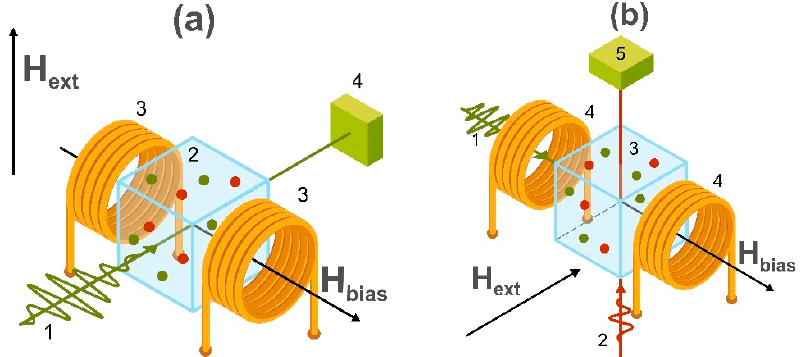
Figure 8. Schematic images of two main geometries of the optically pumped atomic magnetometer. In ( a ), the measuring scheme includes a circularly polarized pump beam (1) passing through the vapor cell (2) placed into the applied external magnetic field (H ext ) and bias magnetic field (H bias ) generated by the Helmholtz coils (3). The detecting system is shown as (4). In ( b ), the measuring scheme includes a circularly polarized pump (1) and linearly polarized probe beams (2) passing through the vapor cell (3) placed into applied external and bias magnetic fields generated by the Helmholtz coils (4). The probe beam detecting system is shown as (5).